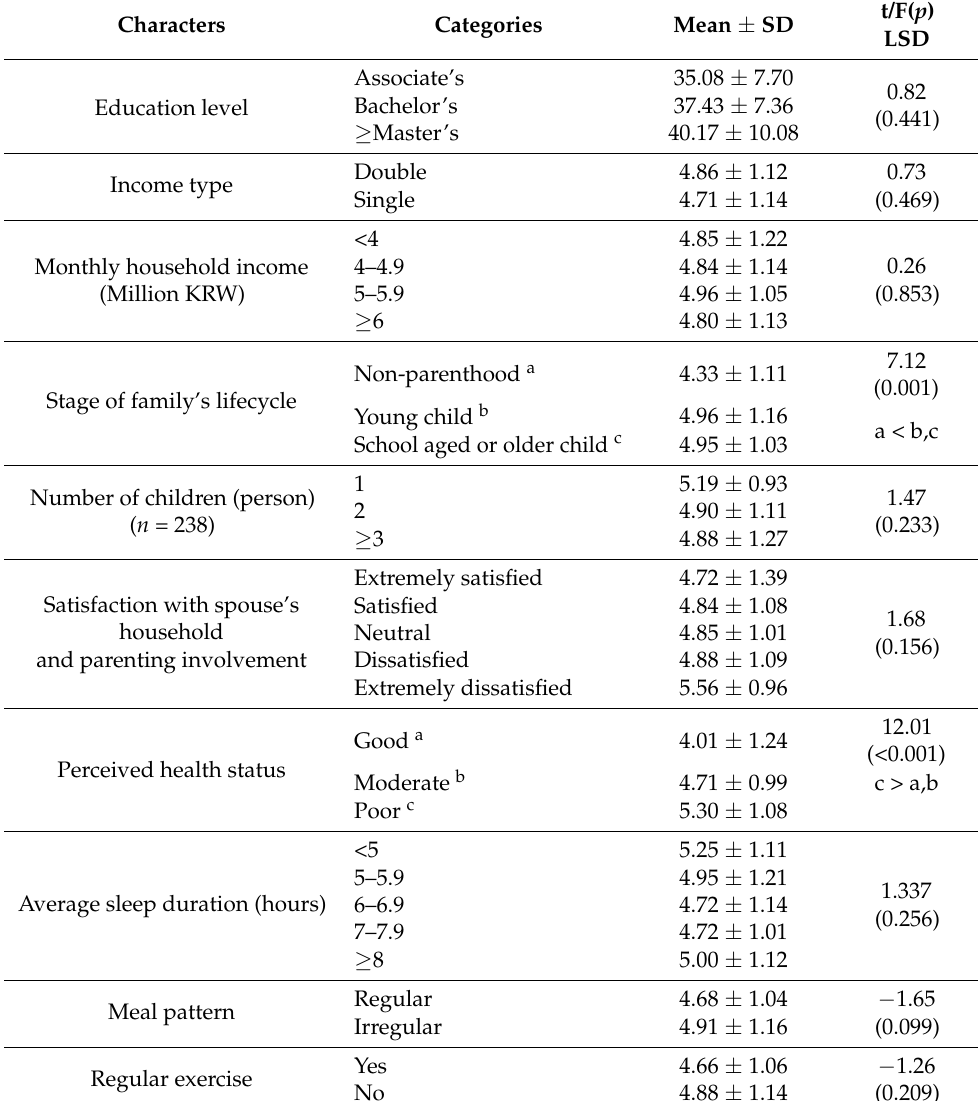
Table 4. Differences in WFC according to general characteristics ( n =